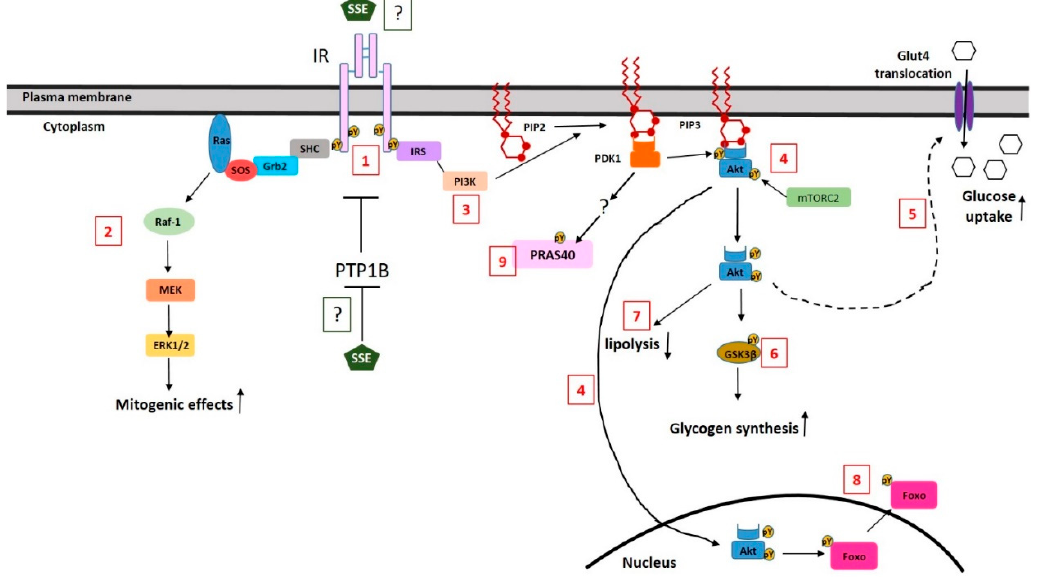
Figure 7. A schematic illustration of the effects of SSE on insulin signaling and the suggested mechanism. SSE induced a low level of IR phosphorylation (1). This phosphorylation might be the result of phosphatase inhibition or a direct binding and activation of the receptor by SSE. SSE activates MAPK pathway in a similar time course as induced by insulin (2). SSE activates the PI3K-Akt pathway (3); although a low level of Akt phosphorylation is detected, Akt is translocated to the membrane and the nucleus (4). Metabolic effects of the PI3K-Akt pathway are regulated by SSE, similar to insulin effects; glucose uptake (5) is increased via Glut4-facilitated transport, while GSK3 β is phosphorylated, indicating increased glycogen synthesis (6) and lipolysis inhibition as well (7). In addition, FoxO is phosphorylated and is excluded from the nucleus (8). PRAS40 is also phosphorylated following insulin and SSE stimulation in a PI3K-dependent, Akt-independent mechanism. The scheme is based on results of this study and on our previous data [29,31].